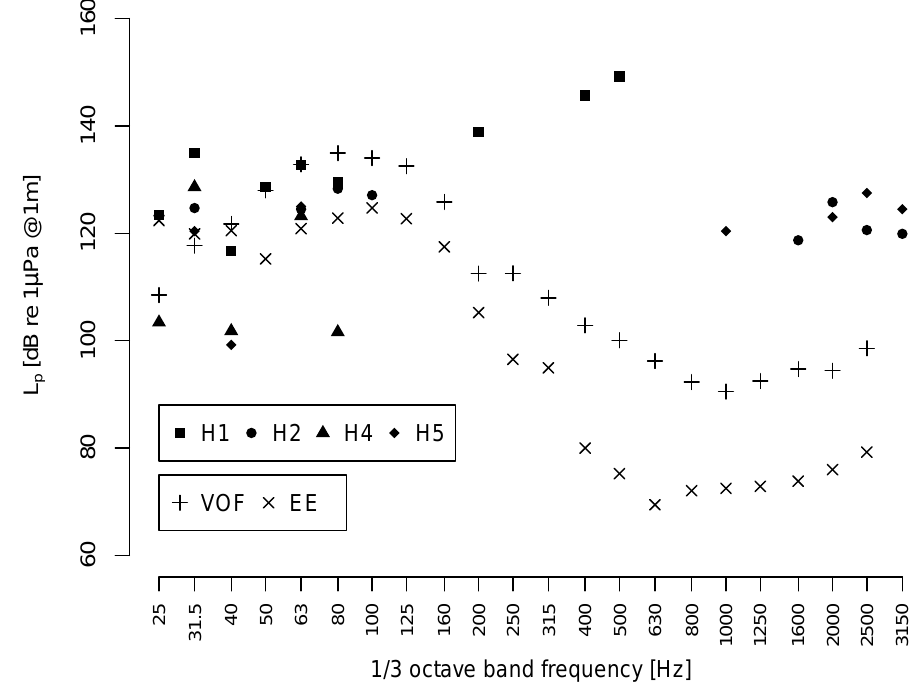
Figure 33. Measured and simulated cavitator noise comparison in 1/3 octave